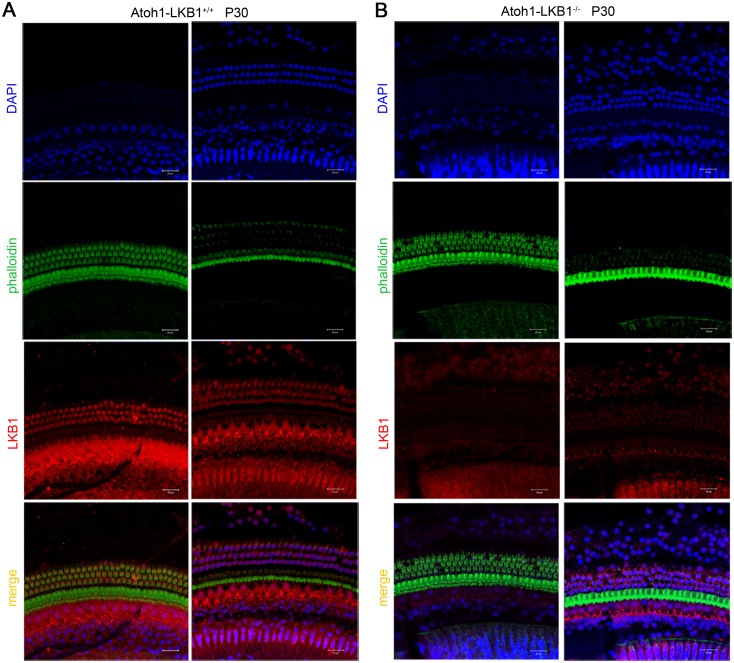
Expression pattern of LKB1 in cochlea hair cells of mice at p30.(A) Confocal images of cochlea hair cells in wild-type mice. LKB1 was expressed from the cuticular plate to the nuclei of hair cells. Left panel: LKB1 expression was detected in the cuticular plate. Right panel: LKB1 expression was detected in the hair cell nuclei. (B) Confocal images of cochlea hair cells in the Atoh1-LKB1-/- mice. LKB1 was deleted in the cochlea hair cells of the inner ear. Left panel: LKB1expression was not detected in the cuticular plate. Right panel: LKB1 expression was not detected in the hair cell nuclei. Green, phalloidin, an F-actin specific dye. Red, LKB1. Bule, Dapi. Scale bar: 20 μm.